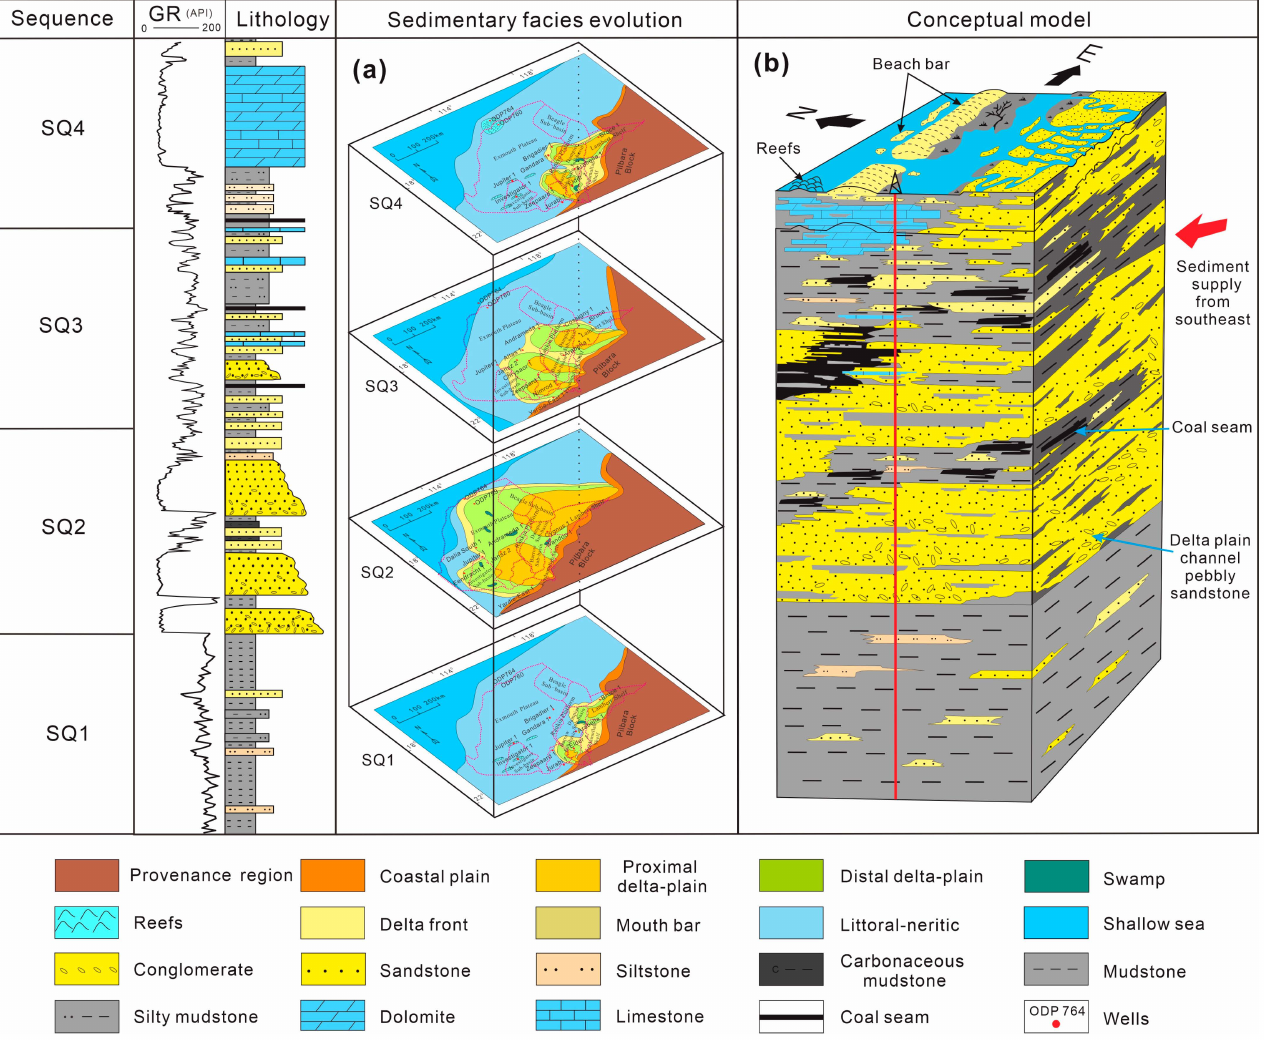
Figure 9. The lithology, GR wireline log feature, facies distribution and evolution, and the related three-dimensional conceptual model of the Triassic strata from the Locker Shale to the Brigadier Formation in the NCB. ( a ) The sedimentary facies maps of the SQ1 to SQ4 indicate the distribution pattern of the shallow water delta system. ( b ) The three-dimensional conceptual model of the the Locker Shale to the Brigadier Formation with typical lithologic